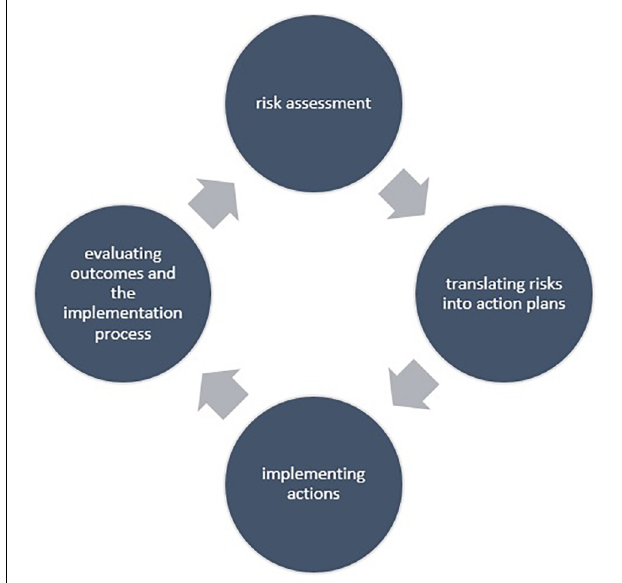
FIGURE 1 | Schematic overview of the main steps in the psychosocial risk management approach